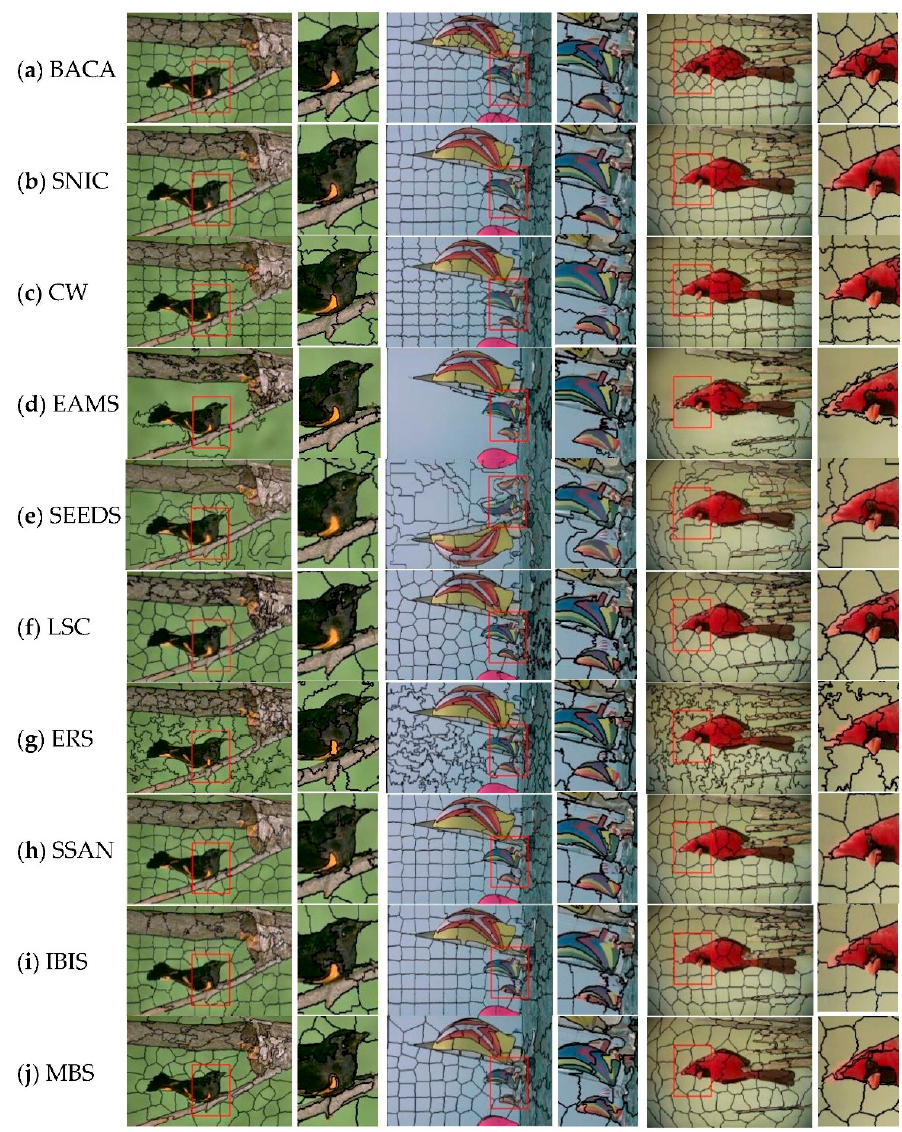
Figure 8. Visual comparison of segmentation results with 100 expected superpixels. ( a ) BACA; ( b ) SNIC; ( c ) CW; ( d ) EAMS; ( e ) SEEDS; ( f ) LSC; ( g ) ERS; ( h ) SSAN; ( i ) IBIS; ( j ) MBS. Alternating columns show each segmented image followed by the zoom-in